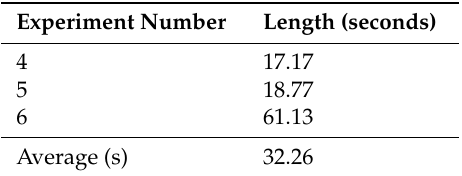
Table 3. Total Length in Seconds for the Second Three Experiments.